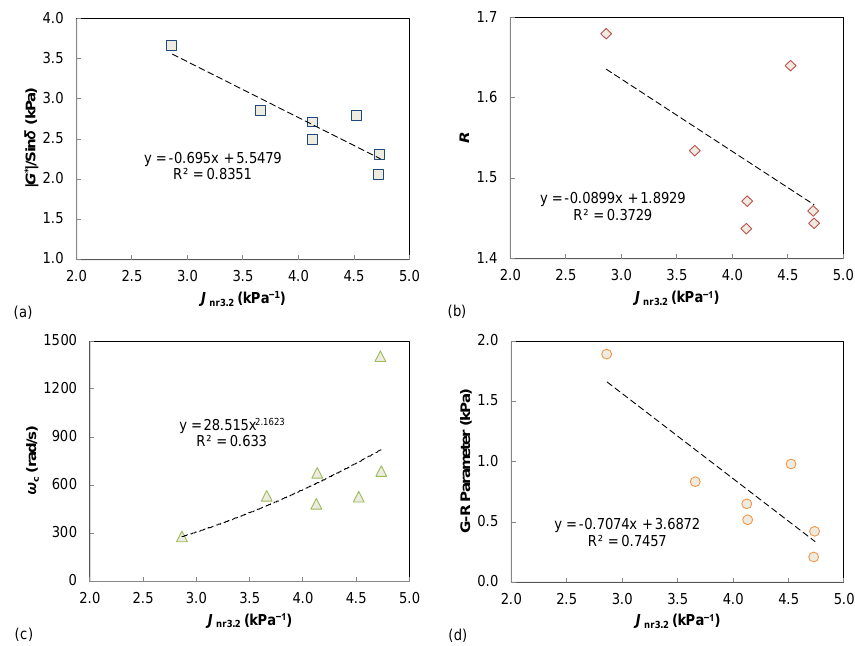
Figure 5. Comparison of J nr3.2 and LVE parameters: ( a ) | G* |/sin δ ; ( b ) R ; ( c ) ω c ; ( d ) G-R parameter.